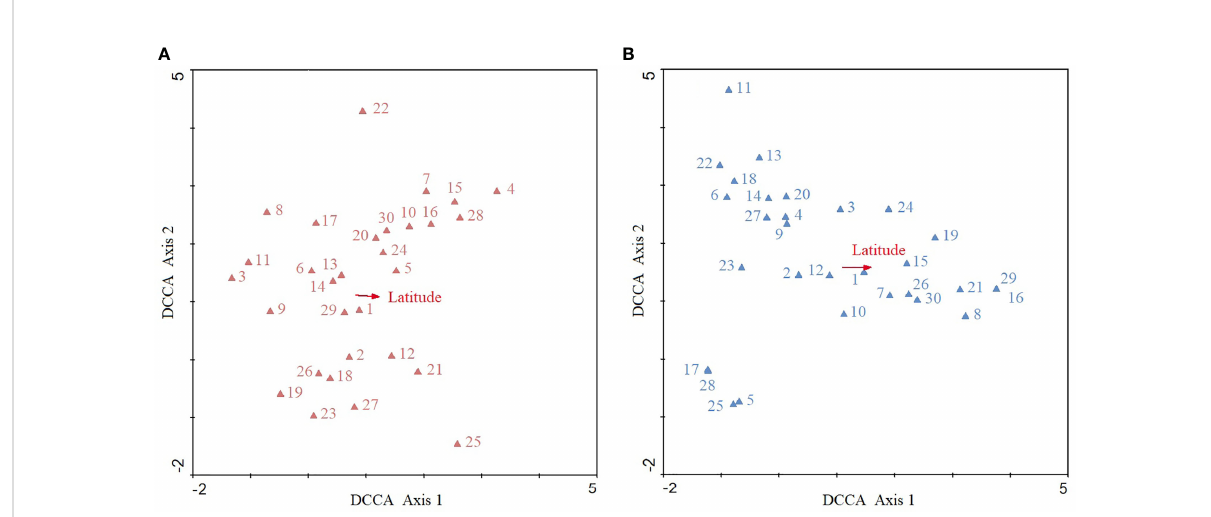
FIGURE 5 DCCA ordination diagrams of 30 dominant plant species of the A . philoxeroides communities in terrestrial (A) and aquatic (B) habitats along a latitudinal gradient. The triangle is the optimal distribution position of each plant species along the latitudinal gradient. The arrow indicates the direction of increase in latitude from the ordination centre. The vertical distance between the triangle and vector represents the correlation between the species distribution and latitude. Arabic numbers are codes of the dominant plant species (as Table 1 shows for terrestrial and aquatic habitats).